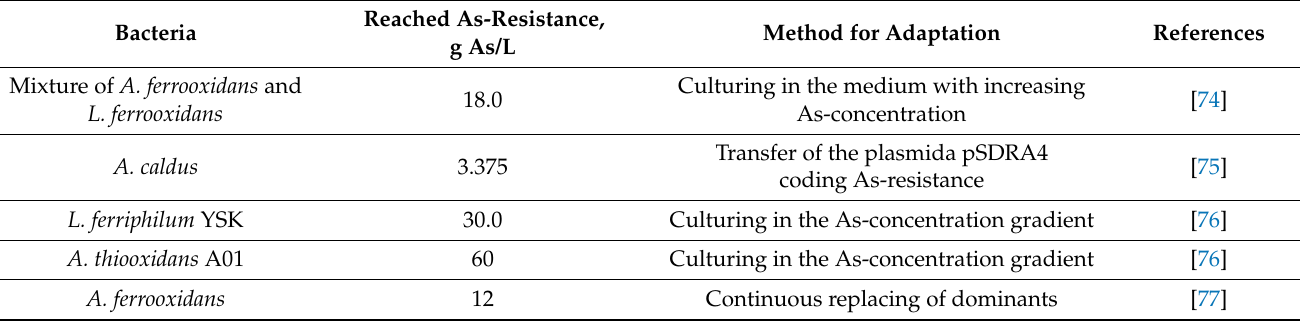
Table 5. Adaptation of leaching bacteria to